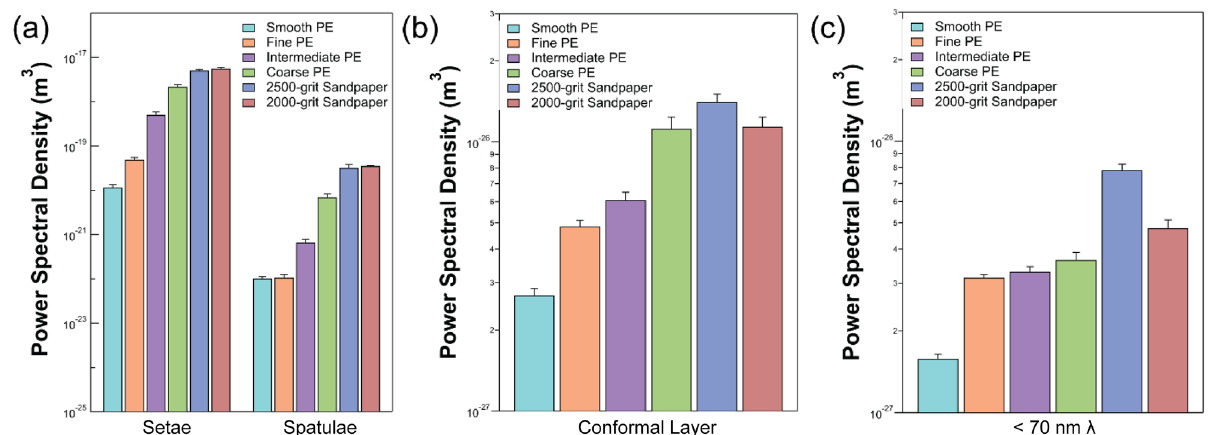
Figure 5. ( a , b ) Power spectral density (PSD) averaged over wavelengths of surface roughness described by Persson 28 . Setae and spatulae length scales (defined in Fig. 4) are displayed in ( a ), while the conformal layer length scale is displayed in ( b ). Note that roughness at the length scales of the skin/underlying digital anatomy (as defined by Persson 28 ) was not present in the substrates. Variation in mean PSD between substrates does not correspond to our live gecko attachment experiments at any of the levels described by Persson 28 . ( c ) Mean PSD over wavelengths less than 70 nm. Variation in mean PSD is consistent with our maximum shear load data obtained with live